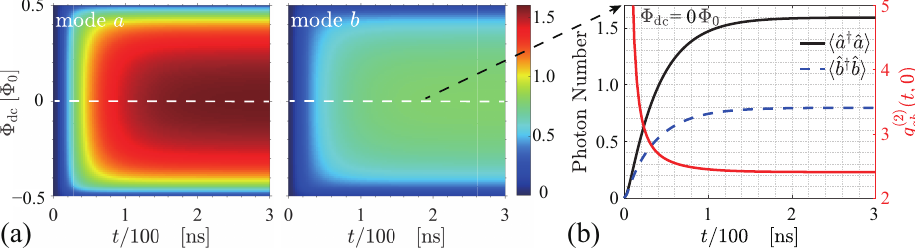
Figure 4. ( a ) Photon number of modes a and b as functions of the dc flux bias Φ dc in the time domain. ( b ) Detailed photon creation along the horizontal white dashed line in ( a ) with Φ dc = 0 where the red line (right axis) is the second-order coherence functions g zero